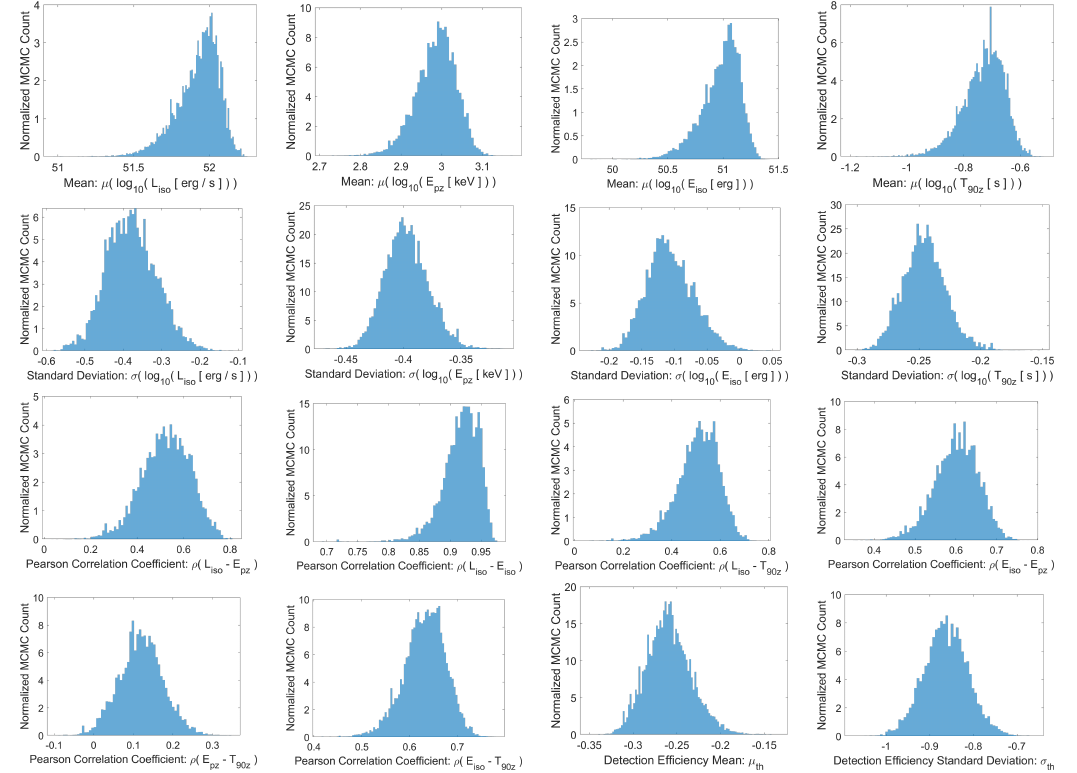
Figure 4. The marginal posterior distributions of the 16 parameters of the SGRB world model. The mean redshifts together with 50% and 90% prediction intervals for the three rate density scenarios are also reported in Table 2. On average, the redshifts of individual BATSE SGRBs can be constrained to within a 50% uncertainty range of 0.51. At a 90% confidence level, the prediction intervals expand to wider a uncertainty range of 1.31.